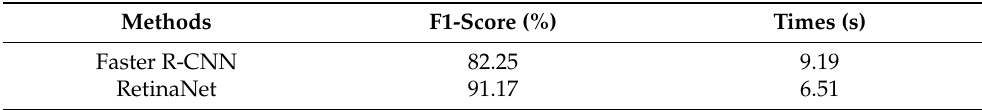
Table 4. Using different methods for wheat ear